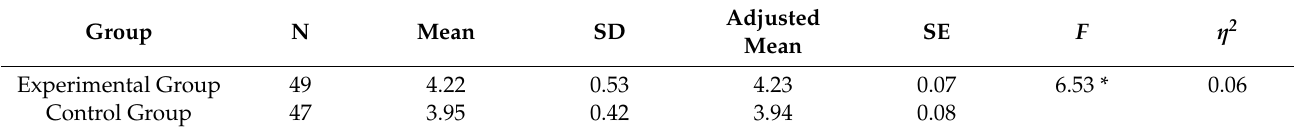
Table 2. The ANCOVA results of students’ learning